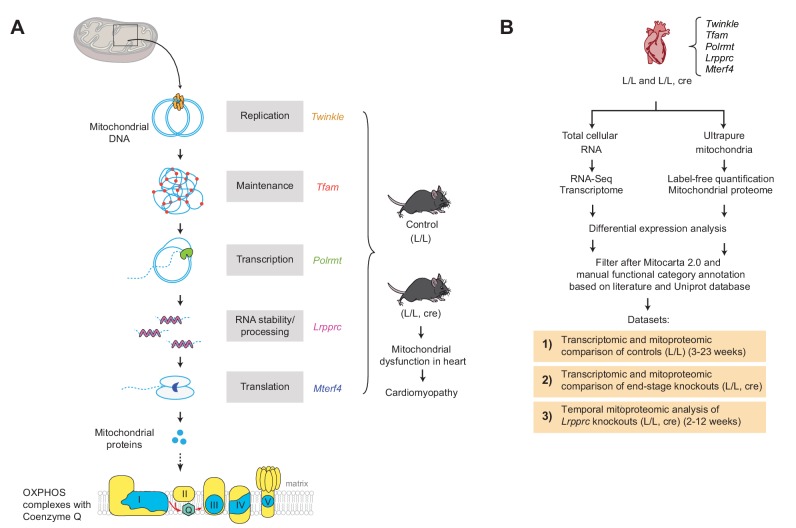
Label-free quantification and comparison of mitoproteomes of mouse hearts with mitochondrial dysfunction.(A) Schematic representation of the tissue-specific knockout strains (L/L, cre) used, with impaired mtDNA gene expression leading to mitochondrial dysfunction and corresponding controls (L/L). Nuclear-encoded mitochondrial proteins are illustrated in yellow and mtDNA-encoded mitochondrial proteins in blue. (B) Experimental workflow of the analysis of the transcriptomes and mitoproteomes from mouse heart generating three distinct datasets (1-3). Files are provided in Supplementary file 1–5, 8 and 9.